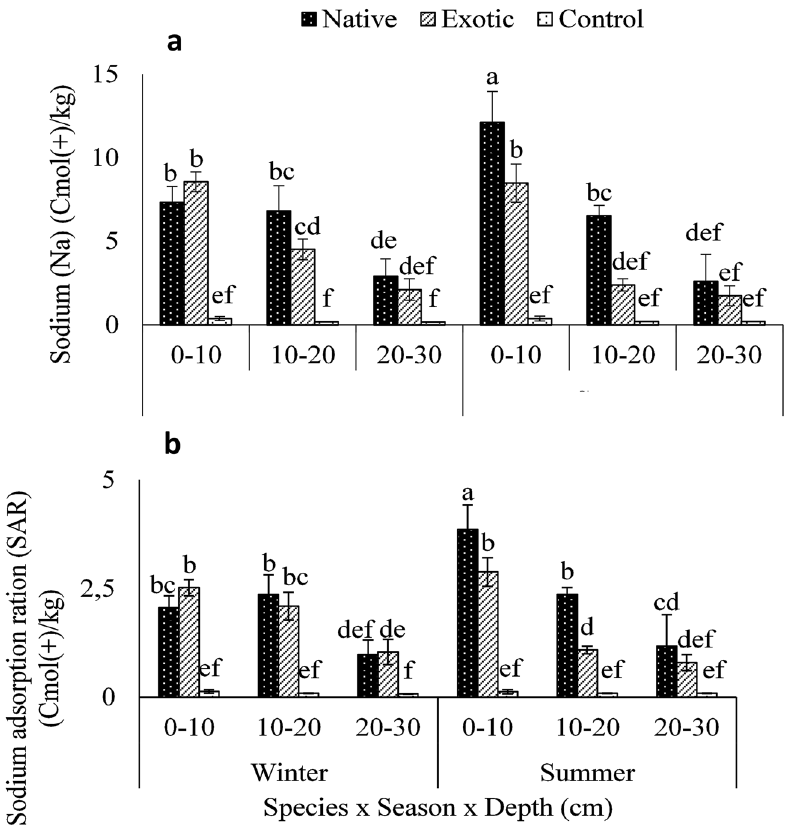
Figure 3. Three way interaction (Species × Season × Depth) Tamarix species (native and exotic) on ( a ) sodium and ( b ) sodium adsorption ratio at three soil depths (0–10, 10–20 and 20–30 cm) in two seasons (winter and summer) in Leeu River. Means followed by different letters are significantly different from each other, with separation of means performed using Turkey’s test HSD. Bars indicate standard